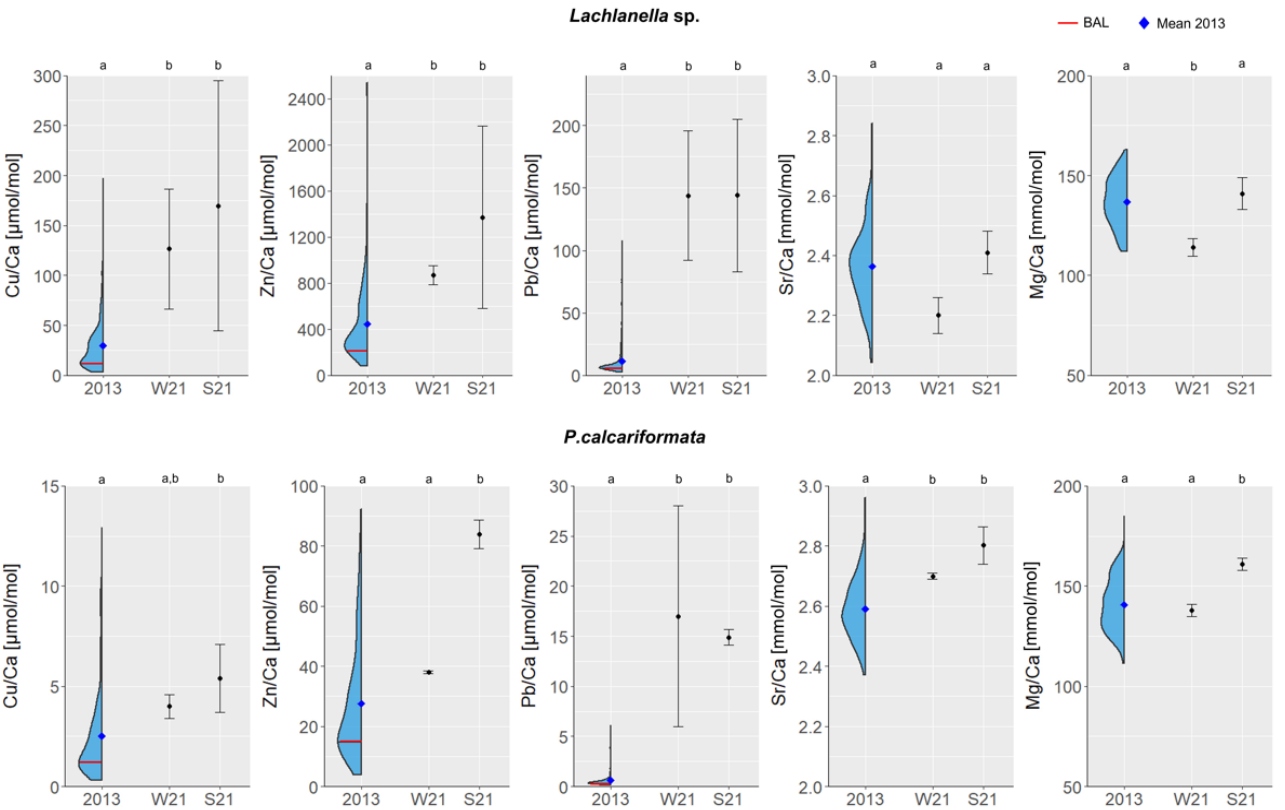
Figure 2. Violin plots of metal/Ca. Single-chamber 2013–2014 LA-ICPMS records are compared with mean whole-shell winter (W21) and summer (S21) 2021 ICPMS ratios. Red horizontal lines mark the BAL ratio for each anthropogenic metal, Cu, Zn and Pb (see text for an explanation about the BAL calculation). The blue diamond indicates the average metal/Ca of all single-chamber 2013–2014 LA-ICPMS analyses. Error bars represent 1 SD. Letters represent the results of the groups’ comparison test. Note the different concentration scales (y axes) of the HMs between the two species. Table 3. Metal/Ca of different foraminifera species from published records. The ratios represent the values of control treatments/field samples. M = miliolid, R = rotaliid.